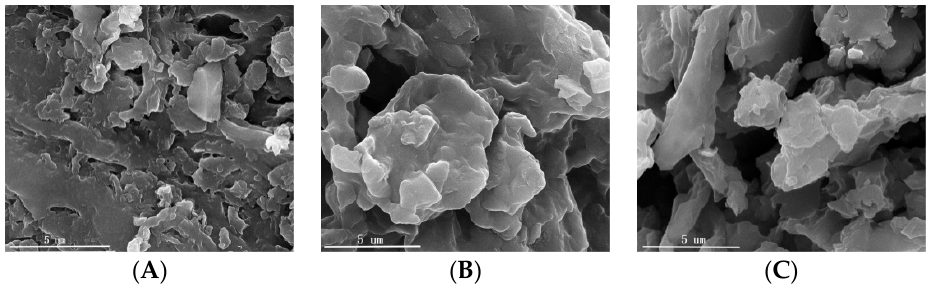
Figure 1. SEM images of ( A ) HDB, ( B ) MHDB, and ( C ) MHDB after adsorption of